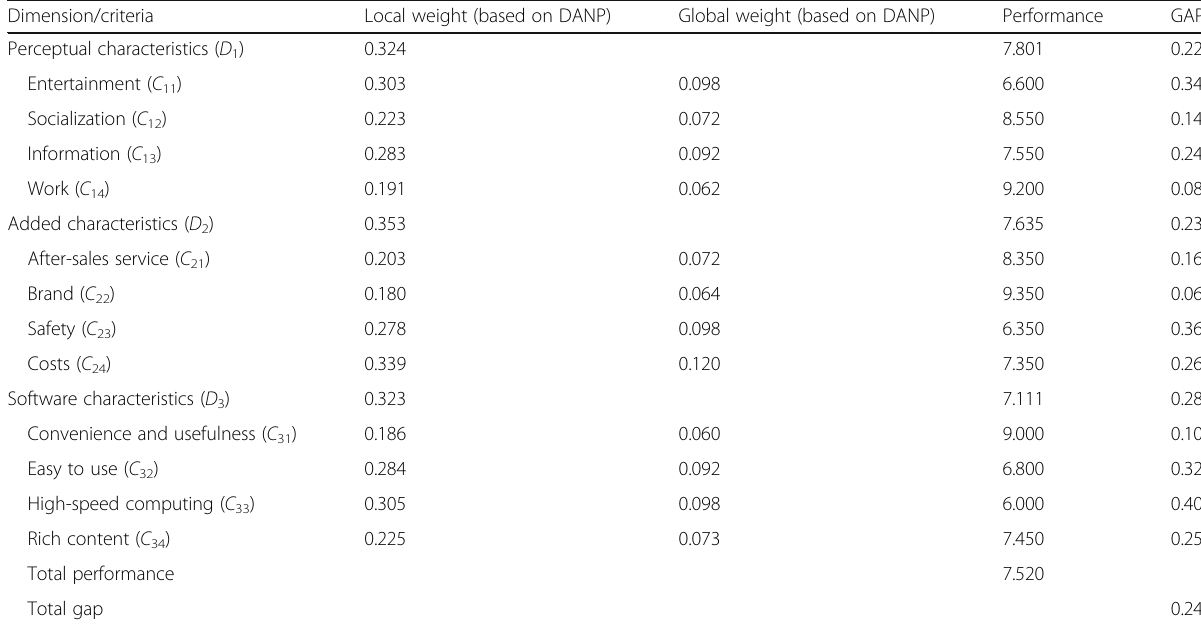
Table 4 Evaluation of the research performance of the VIKOR method Dimension/criteria Local weight (based on